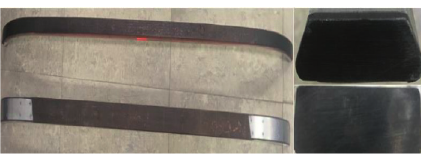
Figure 16: Trapezoidal and rectangular cross sections of carbon